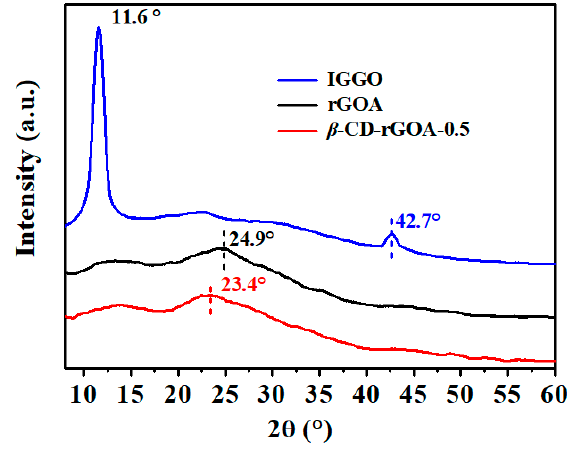
Figure 4. XRD patterns of IGGO, rGOA, and β -CD-rGOA-0.5.